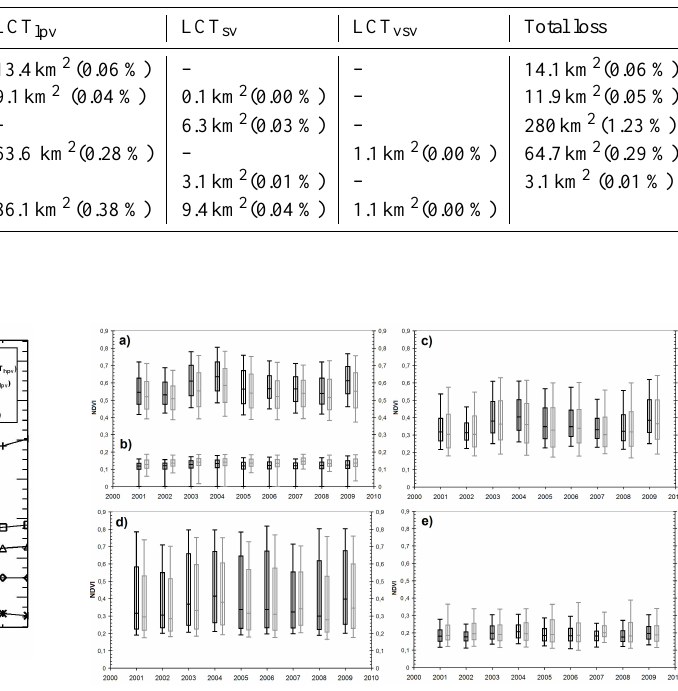
Fig. 9. Mean endmembers of stably classified areas 2001–2009.